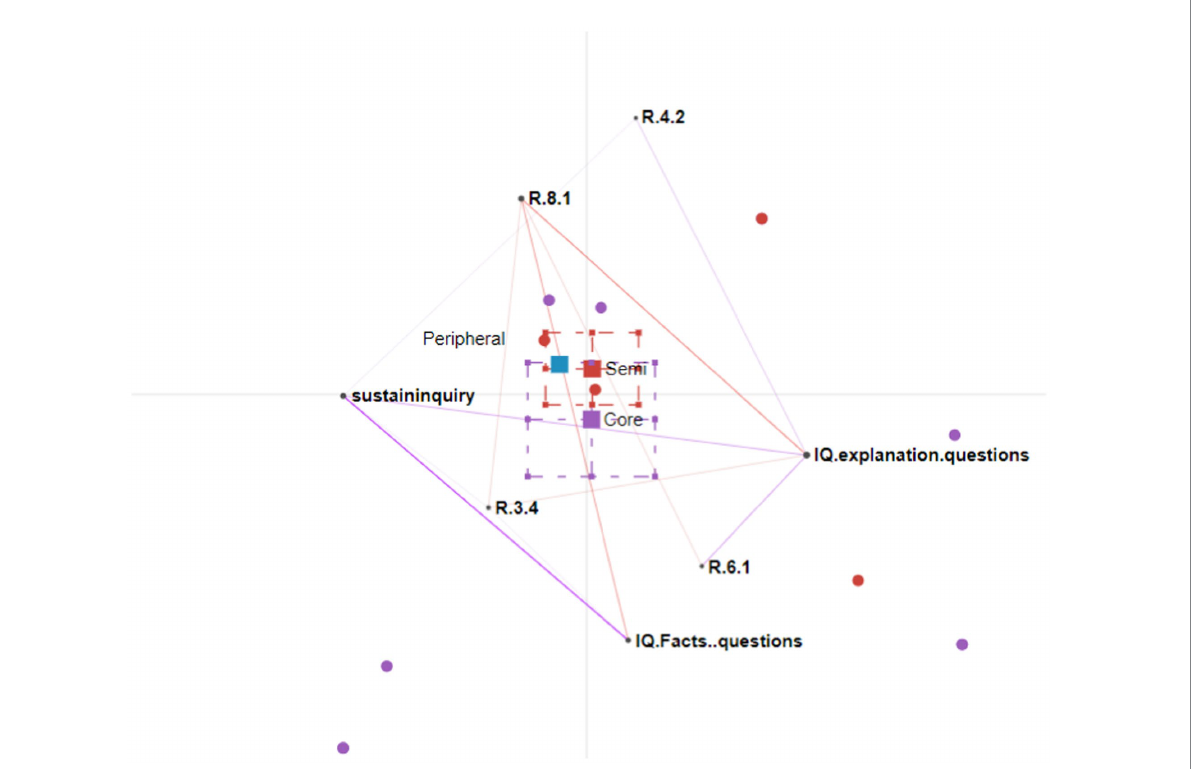
FIGURE 6 Epistemic network analysis graph comparing the regular and leader groups. The leader group’s connections are shown as purple lines; the regular group’s connections are shown as red